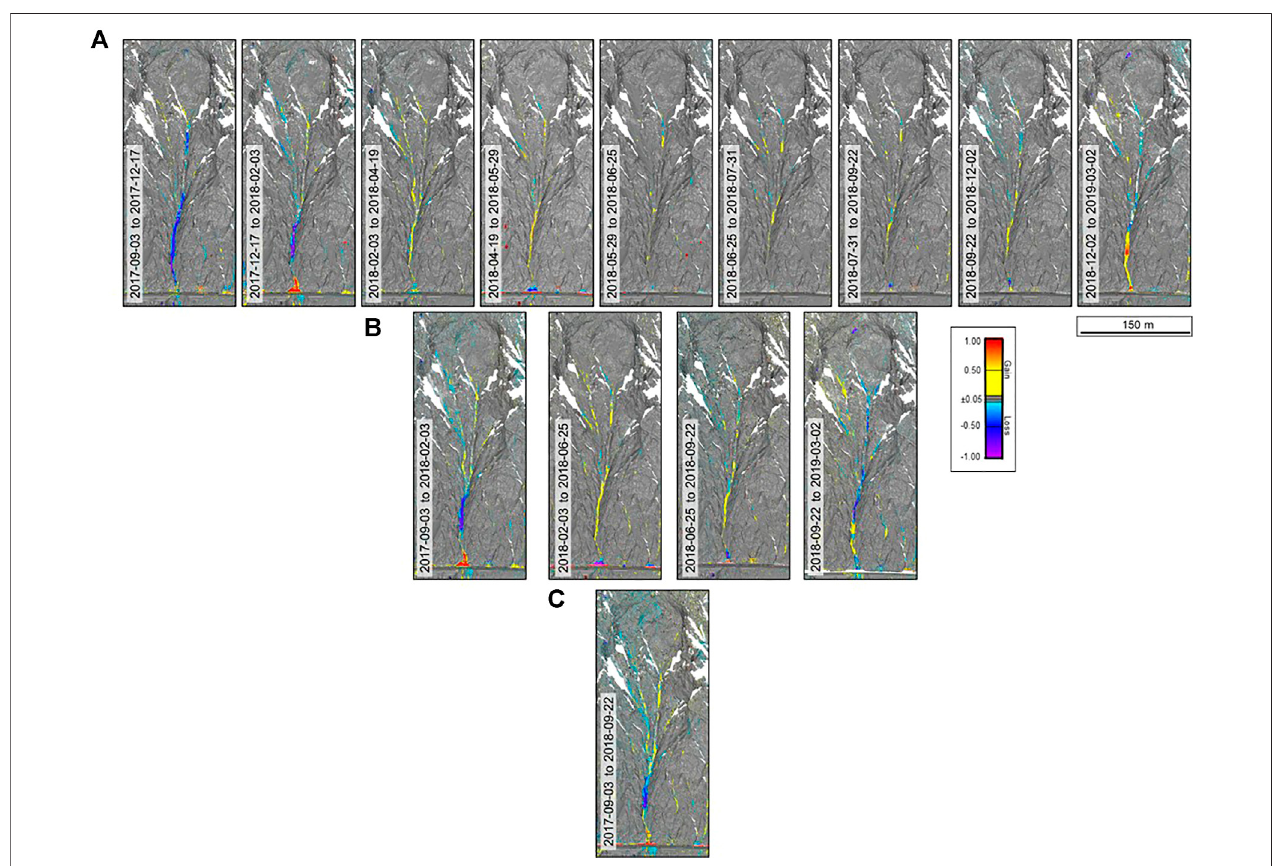
FIGURE 12 | Change detection results for Riegl scans captured of WCW Channel 7, highlighting the implications of the timing of data collection. (A) Full dataset processedwithinchangedetection. (B) Tri-annualdatacollectionwithdatacapturedinFebruary,June,andSeptember. (C)